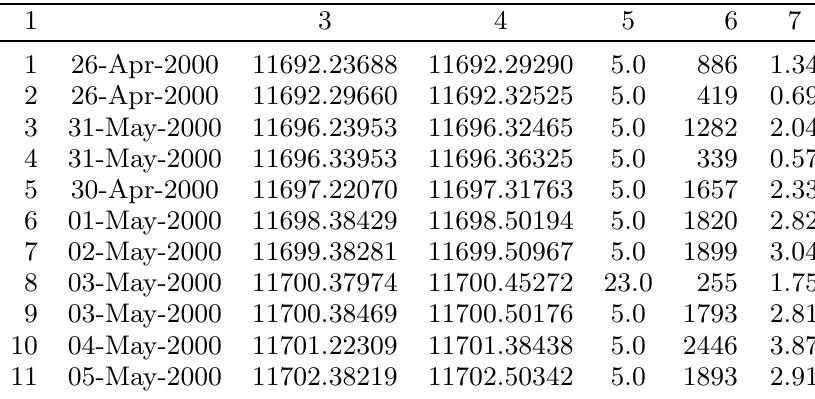
Table 3. Journal of observations of XCov19.